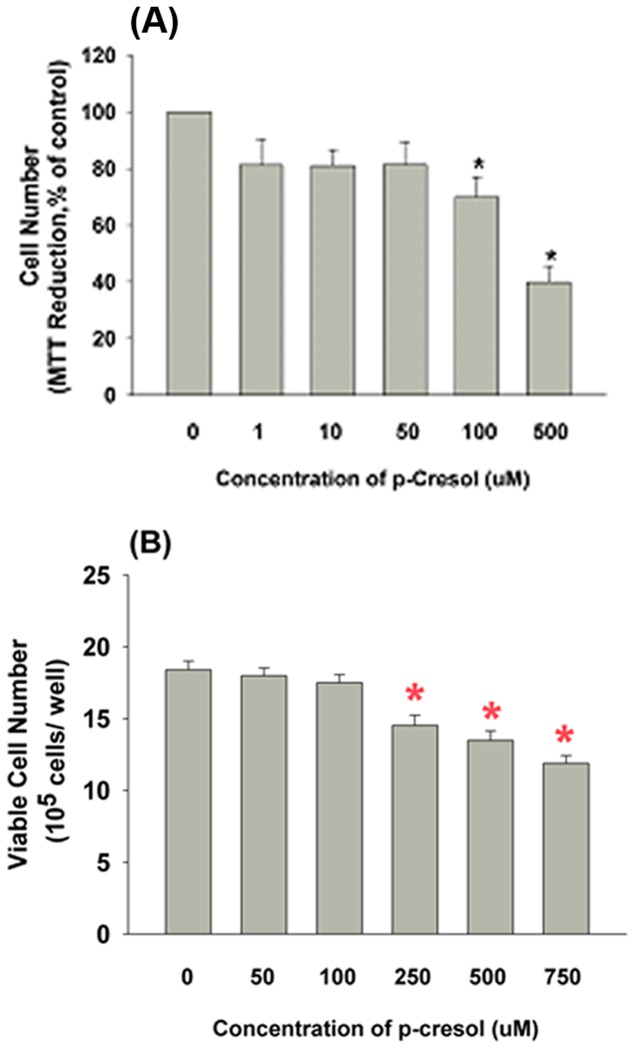
Effect of p-cresol on cell growth of EAHY and U937 cells.(A) P-cresol obviously suppressed the growth of endothelial cells as analyzed by MTT assay (as % of control) (n = 6) and (B) U937 cells (x 105 cells/well) as analyzed by trypan blue dye exclusion technique. *denotes significant difference when compared with control group (n = 13).